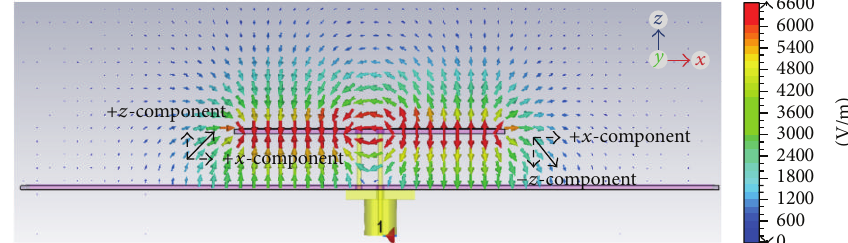
Figure 14: Electric field distribution in the 𝑥 - 𝑧 plane at distances of 20mm from the center of substrate along the 𝑦 -axis at 𝜔𝑡 = 90 ∘ for 𝑔 = 40 mm.